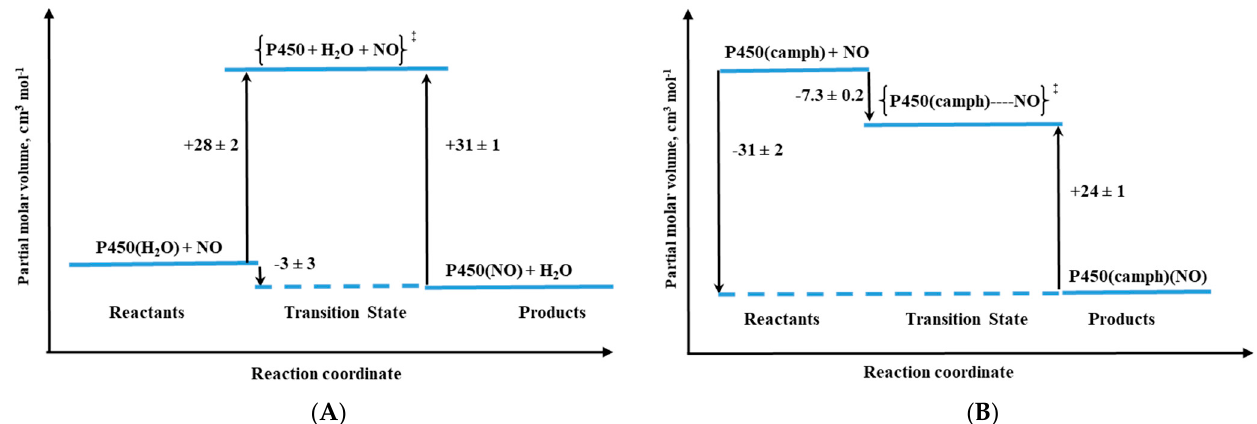
Figure 13. Volume profiles for reversible NO binding to ( A ) substrate-free (P450) and ( B ) camphor bound (P450(camph)) cytochrome.